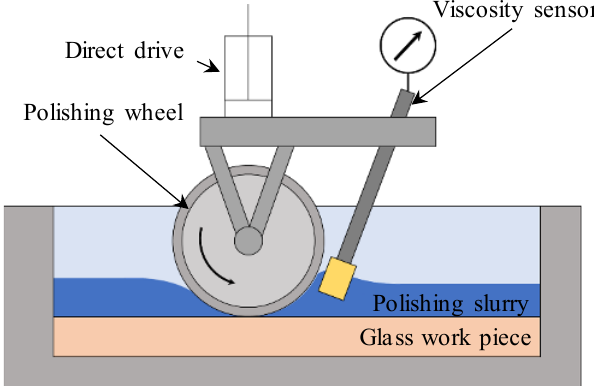
Figure 5: Schematic application of the set up